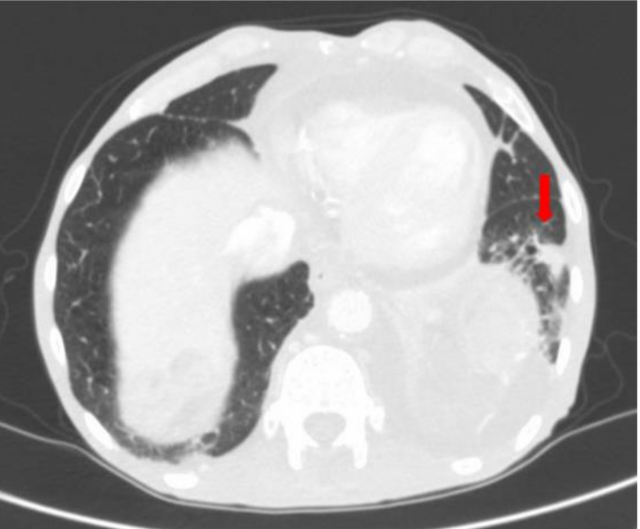
Figure 13. Follow-up CT scan after 9 months with appearance of lung metastases in the left lower